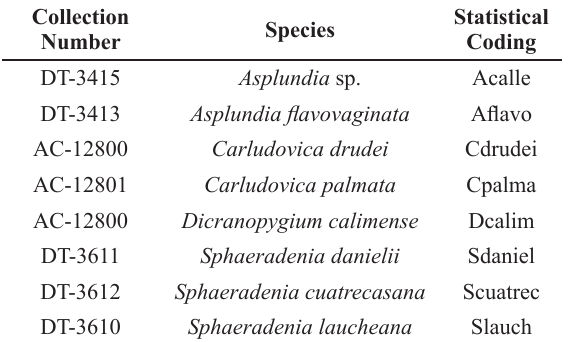
Coding of the Cyclanthaceae specimens